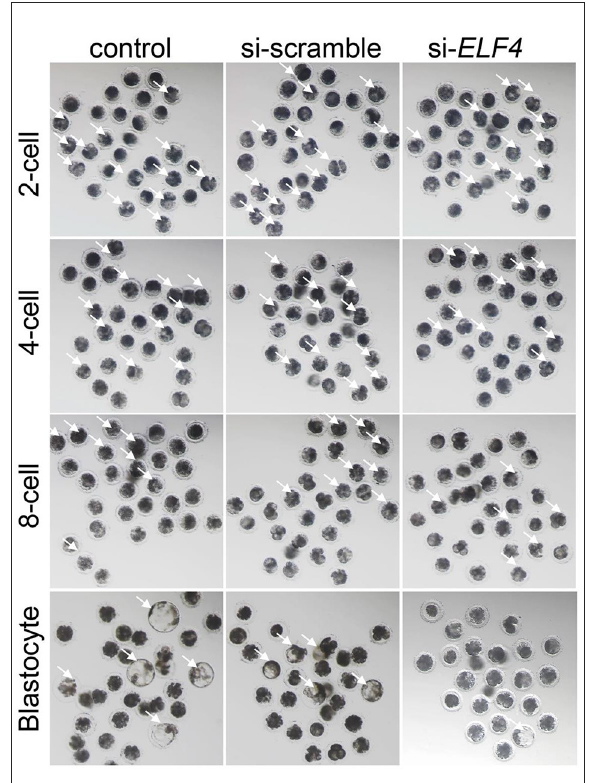
FIGURE3 The knockdown of ELF4 is not conducive to the development of porcine IVF embryos. Bright-field phenotypes of early embryonic